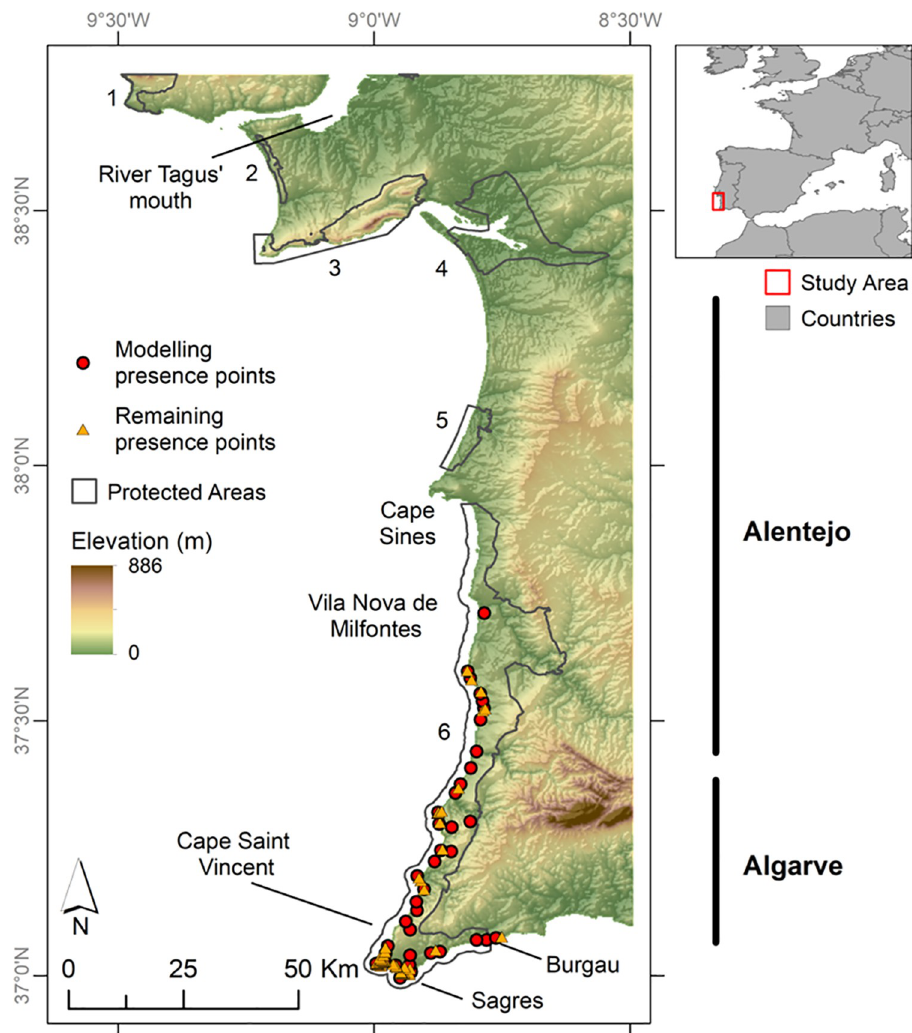
Fig 1. Location of the study area and spatial representation of the presence dataset. The 38 post-thinning presence points of C . ladanifer subsp. sulcatus , which were used to produce the ENM and its future projections, and the remaining 64 presence points, over an elevation layer [23]. Protected areas [24] are displayed as follows: 1 –Sintra- Cascais Natural Park; 2 –Costa da Caparica Fossil Cliff Protected Landscape; 3 –Arra´bida Natural Park; 4 –Sado Estuary Natural Reserve; 5 –Santo Andre ´ and Sancha Lagoons Natural Reserve; 6 –Southwest Alentejo and Vicentine Coast Natural Park. Other regions, mentioned in the text, are outlined. The top right inset displays the geographical location of the study area on a European and North African frame [25]. This figure was assembled using ArcGIS Desktop v10.8.1 [26]. with a resolution of 30 arc-seconds (approximately 1 km). The Cliff Feature Delineation Tool and Baseline Builder [41], available for the same software, were employed to obtain an accurate characterization of southern Portugal’s coastal cliffs, resorting to the high spatial resolution Digital Terrain Model (2 x 2 m) created from airborne LiDAR data and provided by the Portu- guese General Directorate of the Territory (https://www.dgterritorio.gov.pt/). Transects spaced 5 meters apart were defined (Fig in S1 Appendix) and, along each, points were obtained detailing information like their distance to the shoreline and altitude. The “Top” and “Toe” points (Fig in S1 Appendix)–the cliff’s top and base, respectively–were used to compute the